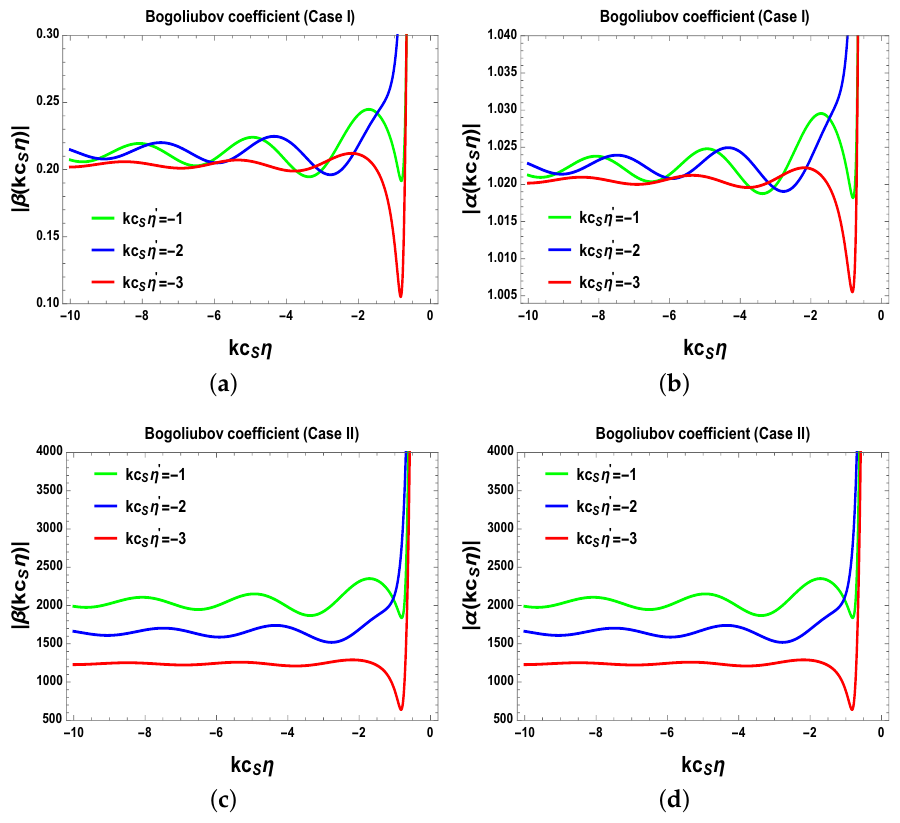
Figure 4. Particle creation for mass profile A for two cases: m ≈ H and m >> H . ( a ) For m ≈ H ; ( b ) For m ≈ H ; ( c ) For m >> H ; ( d ) For m >> H . Here pictures are taken from